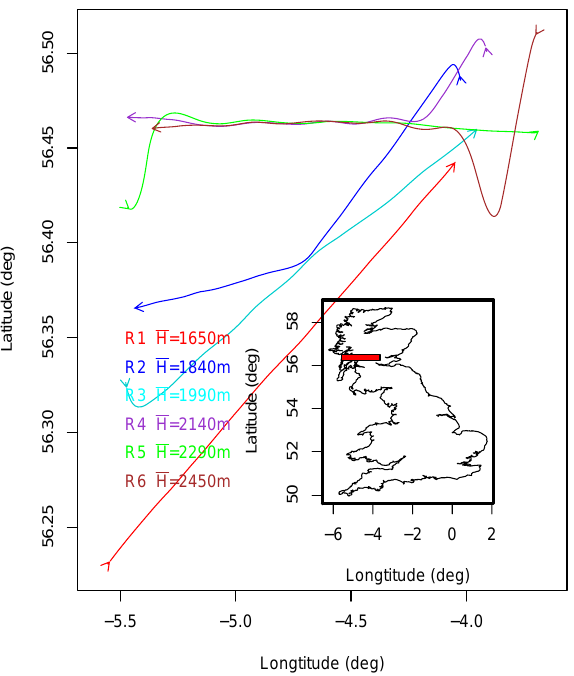
Fig. 3. Flight track of Runs 1–6 and the mean altitude of each run. The red box in the inset shows the location of the figure. Please note the figure is not in proportion in terms of distance in latitudinal and longitudinal